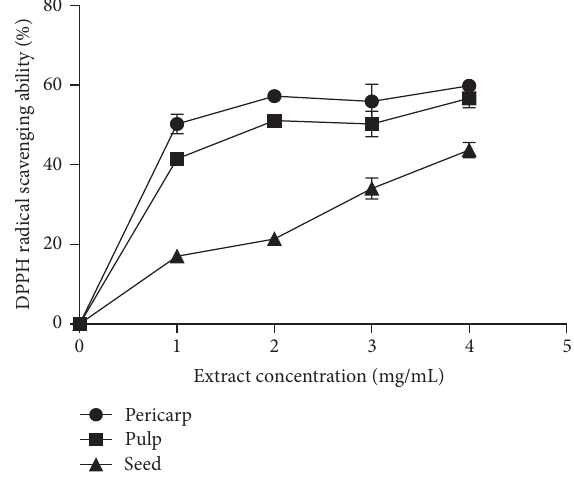
Figure 4: DPPH radical scavenging ability (%) of the aqueous extracts of the pericarp, pulp, and seed of Soursop